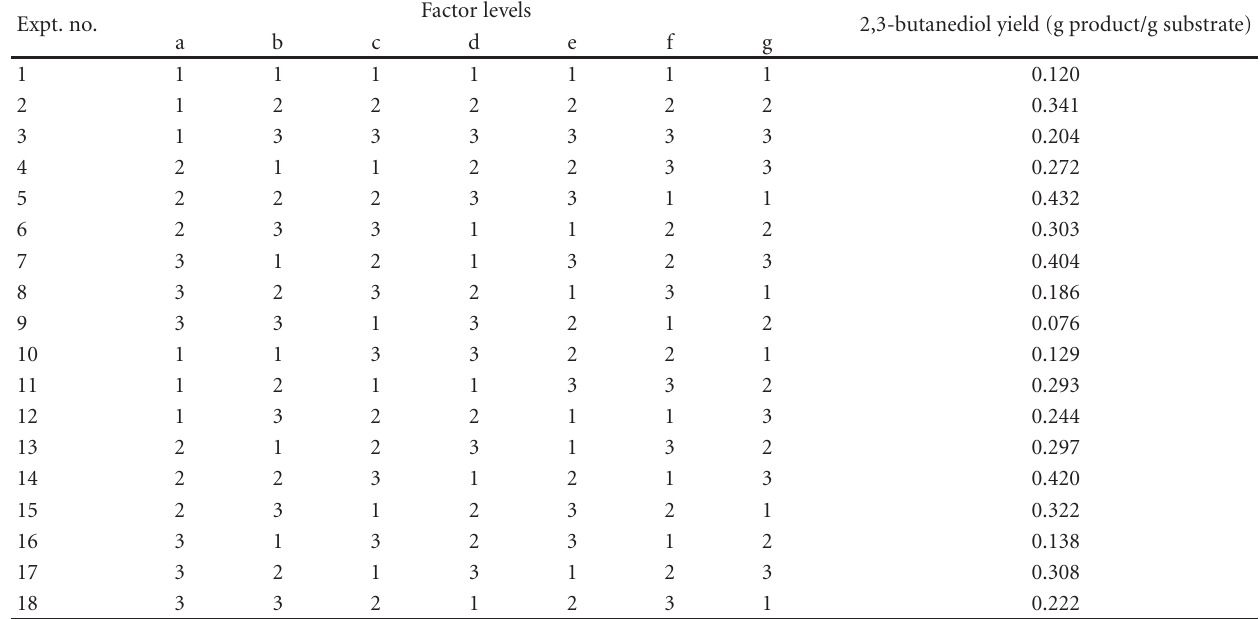
Table 2: The experimental setup (L-18 orthogonal array).